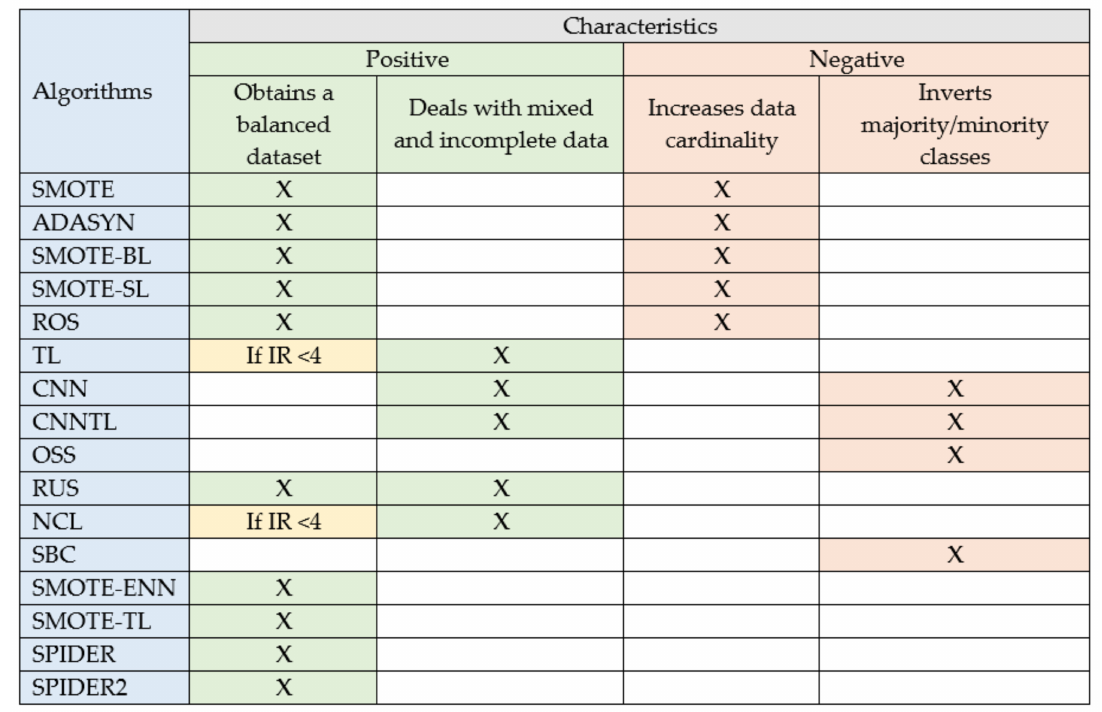
Figure 4. Characteristics of the compared